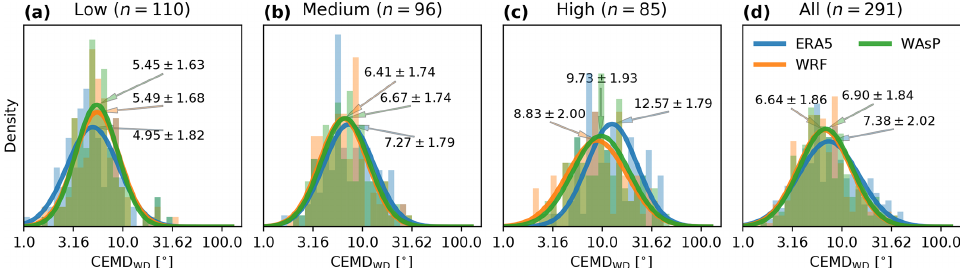
Figure 13. Distributions of the log-transformed samples of circular statistical distance (CEMD WD ) between the observed and modelled wind directions for the three stages of the model chain, separated into groups by the ruggedness index (RIX) category: low (a) , medium (b) , high (c) , and all the samples (d) . The lines are fitted normal distributions that are annotated by the mean and standard deviation ( µ ± σ ) transformed back to physical units of degrees. The number of masts ( n ) in each category is indicated above each